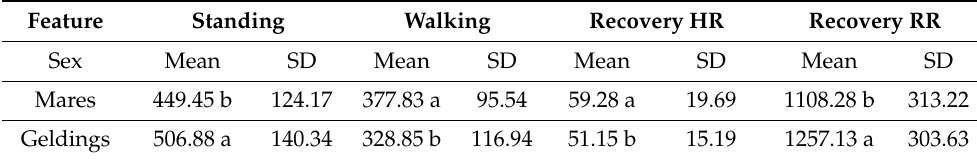
Table 10. Significantly differing features within the sex